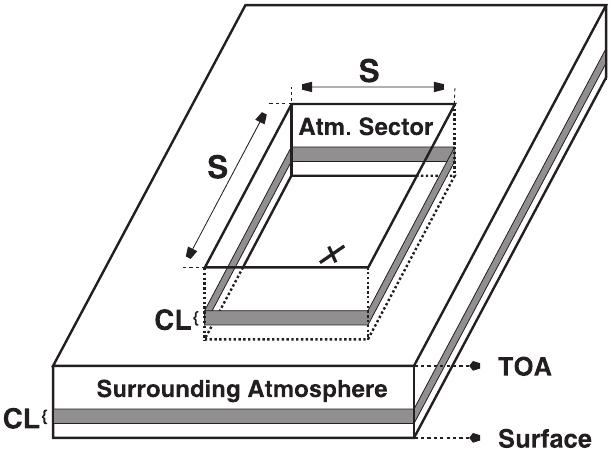
Fig. 2. Illustration of the atmospheric subdivision in a sector and its surrounding. The quadratic sector has a base size of S km (cid:2) S km and is embedded in a horizontally infinite atmosphere. Base and top of clouds in the sector as well as in the surrounding atmosphere are identical. The vertical cloud extension is denoted by CL . X marks sector center. TOA is the abbreviation